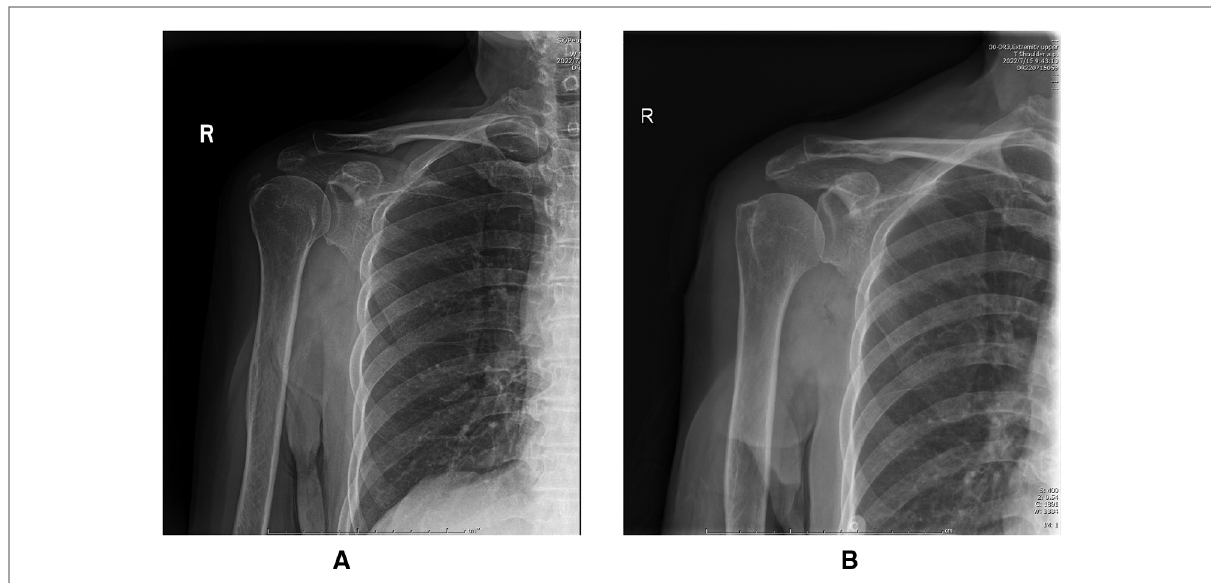
FIGURE 2 ( A ) Preoperative x-ray of the patient with supraspinatus calci fi c tendonitis calci fi cations. ( B ) 1 week after surgery, calci fi cations cannot be detected on